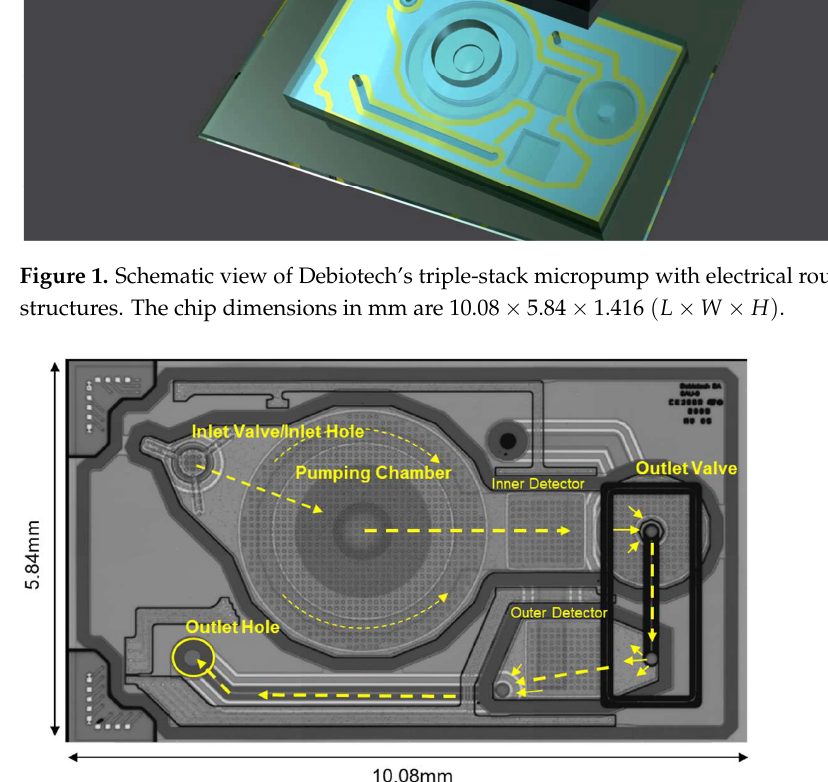
Figure 2. Top view of the MEMS micropump developed by Debiotech (IR microscopy). The fluid pathway is indicated by yellow arrows. A rectangular glass cover is glued above the outlet valve to connect fluidically the outer detector and to allow the outlet port to be on the same side as the inlet port.